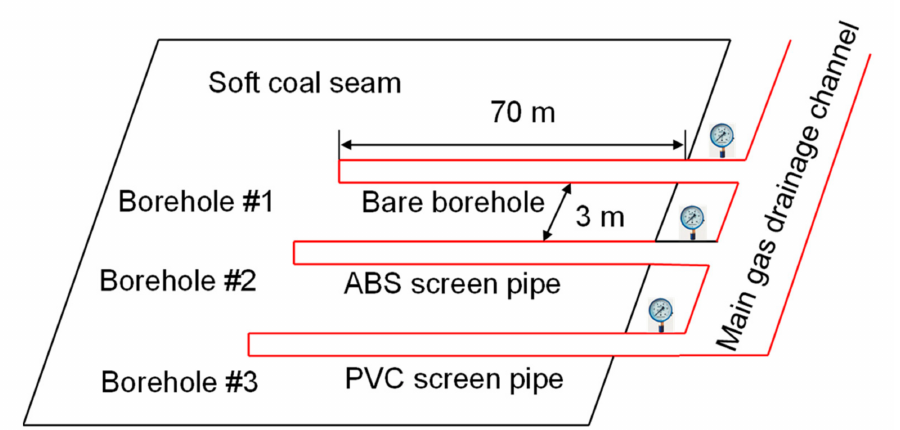
Figure 10. Schematic diagram of borehole